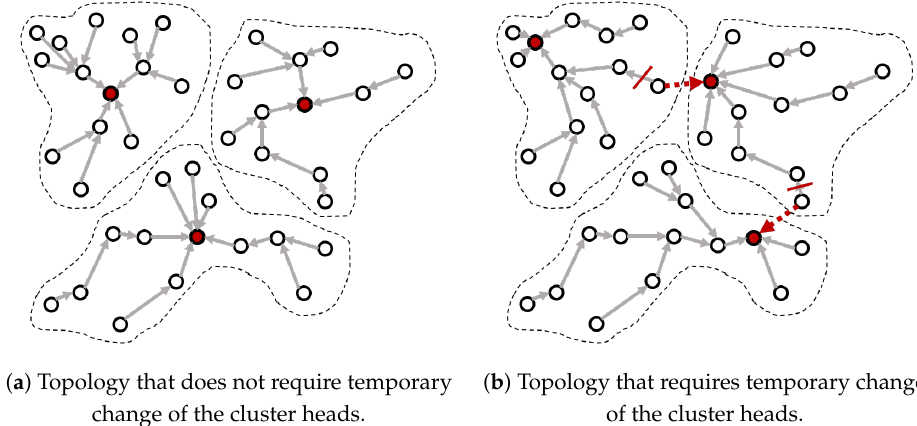
Figure 5. Temporary change of the cluster heads during the current